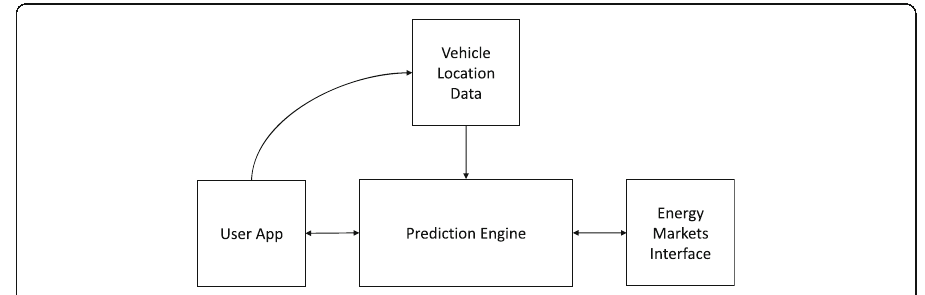
Fig. 1 High-level interfaces for the proposed V2G aggregator